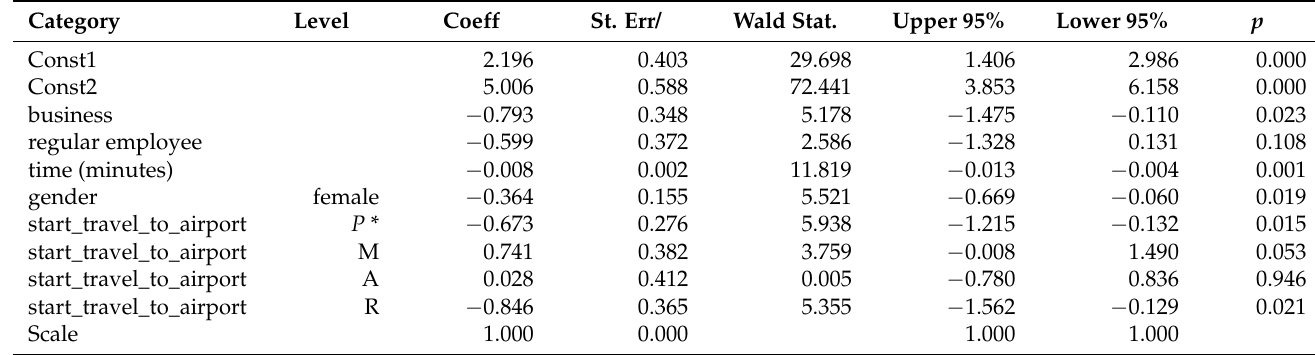
Table 5. Results for ordered logit for assessing the trip duration.